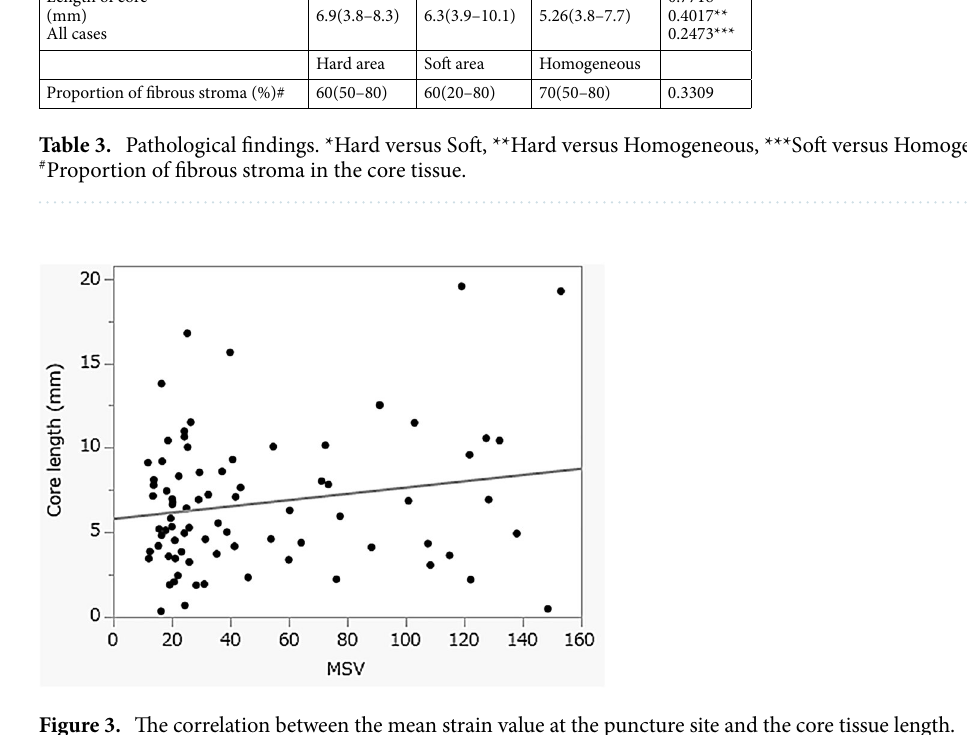
Figure 3. The correlation between the mean strain value at the puncture site and the core tissue length. (R 2 = 0.0344: P =